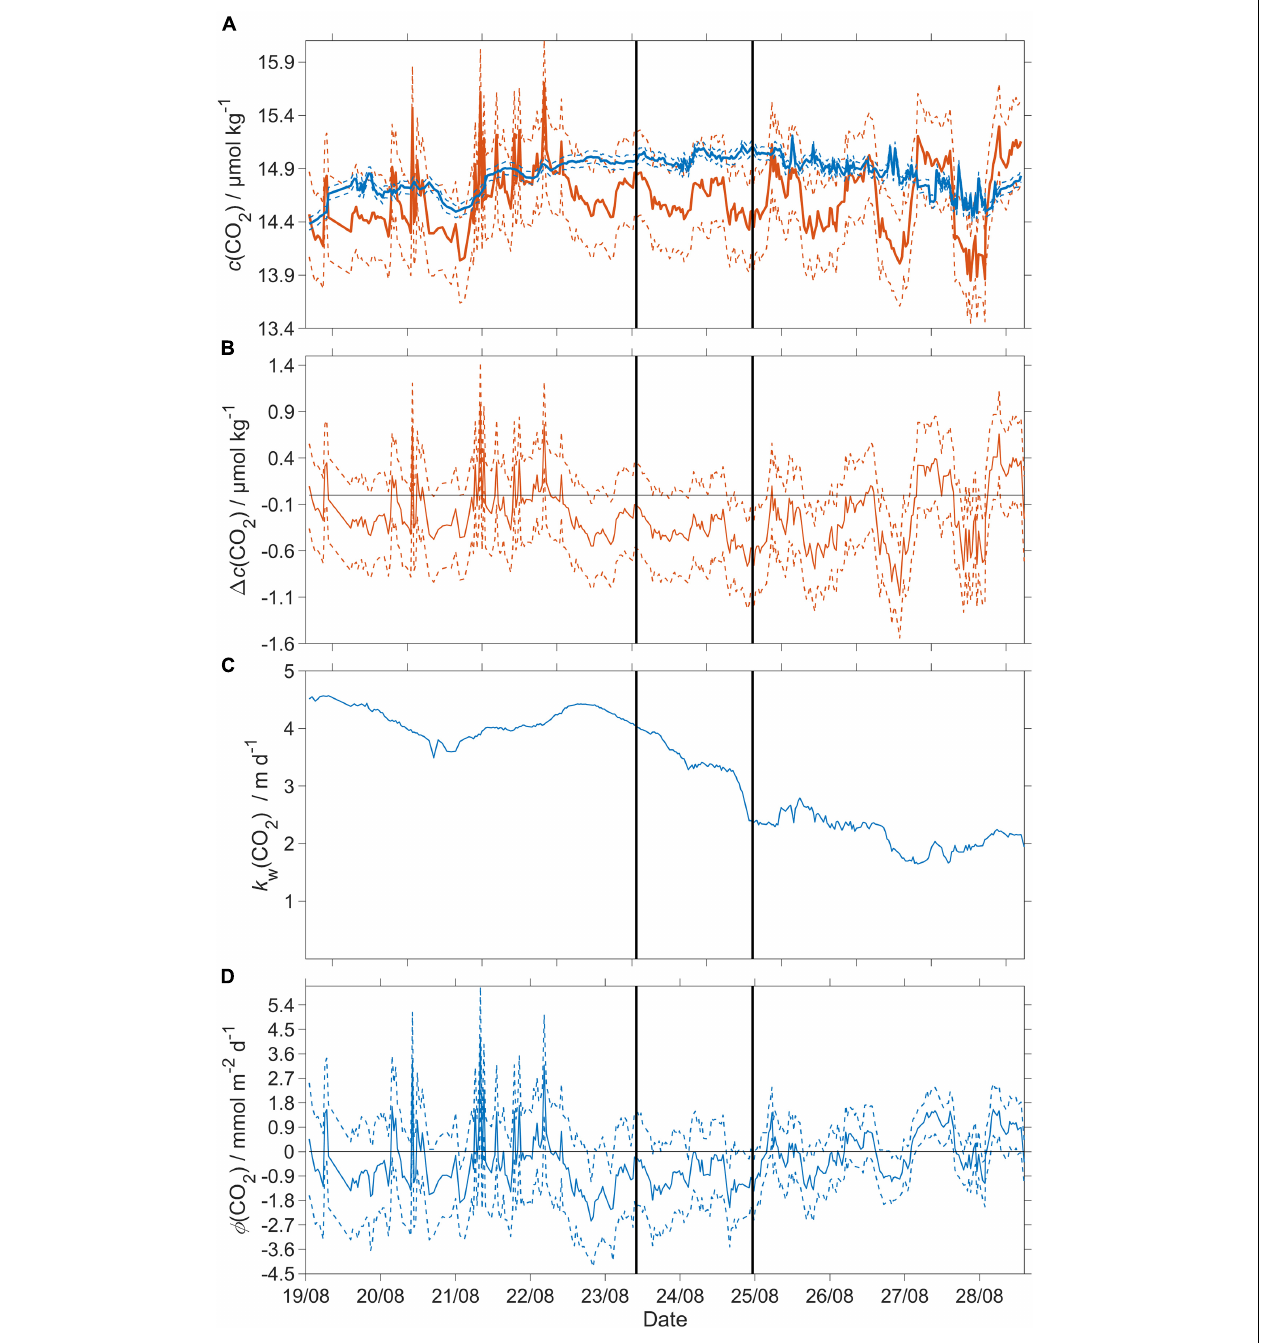
FIGURE 9 | CO 2 air-sea flux and related quantities. Dashed lines represent uncertainties and the black vertical lines divide the three regimes. (A) Blue: c sat (CO 2 ), red: c (CO 2 ); (B) (cid:49) c (CO 2 ) = c (CO 2 ) – c sat (CO 2 ), (C) k w (CO 2 ), weighted over the preceding 7 days (Reuer et al., 2007); (D) CO 2 air-sea flux Φ (CO 2 ). The flux from sea to air is positive while that from air to sea is negative. A decrease of x (CO 2 ) by 10 µ mol mol − 1 results in a decrease of atmospheric CO 2 content [ c atm (CO 2 )] of − 0.37 µ mol kg − 1